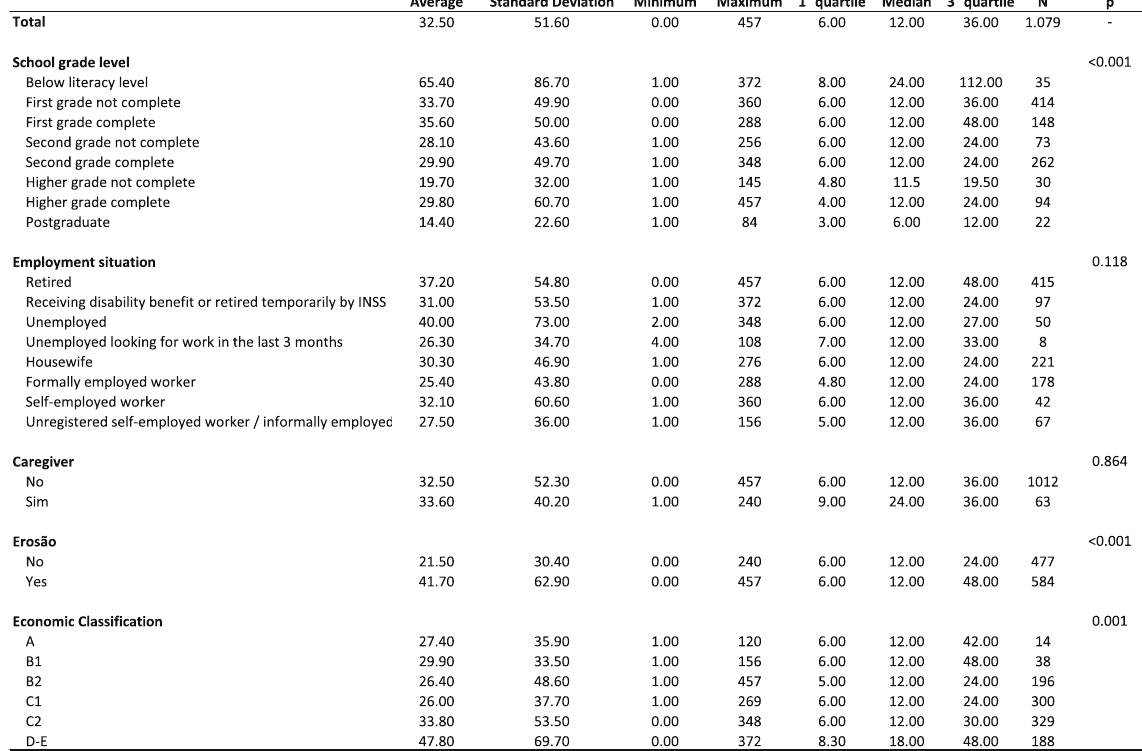
Table 2 Time from symptoms to diagnosis, in